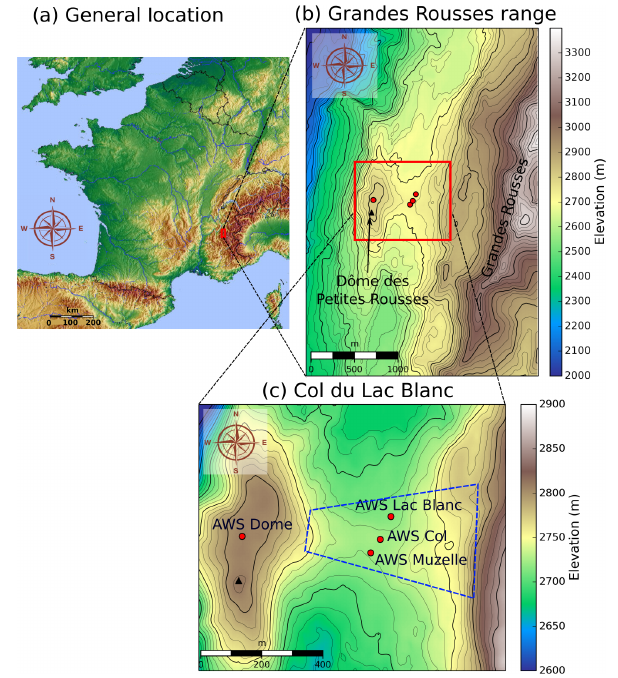
Figure 1. Location of the Col du Lac Blanc experimental site seen at different scales: (a) general location in France, (b) location within the Grandes Rousses mountain range, (c) details of the study area showing the location of the four AWSs surrounding the site and de- scribed in Table 1. The blue dashed area on map (c) shows the ap- proximate area covered by the picture in Fig. 2. Contour line spac- ing is 100m for the major lines and 25m for the minor lines in map (b) and 50 and 10m in map (c)